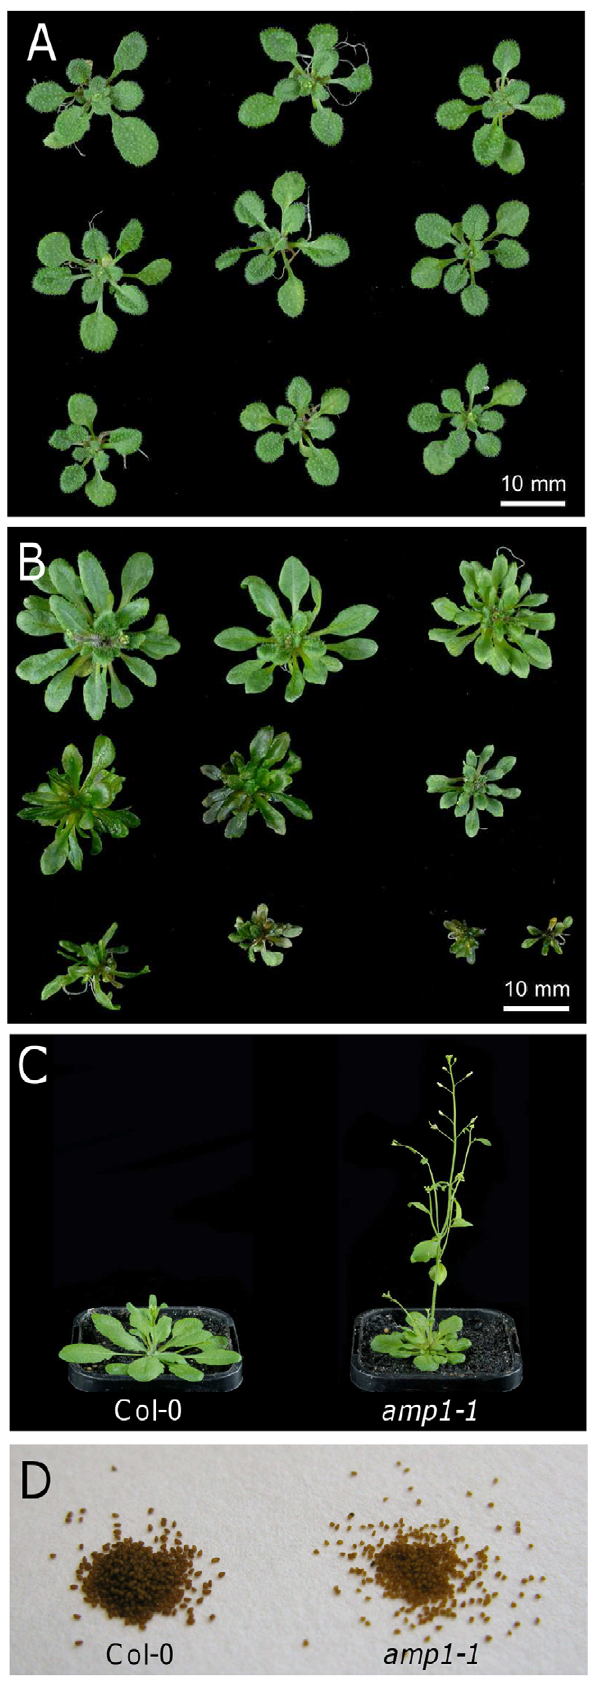
Figure 2. Phenotypes of amp1-1 . Rosettes of Col-0 (A) and amp1-1 (B) at 21 days after sowing. (C) Images of Col-0 and amp1-1 27 days after sowing. (D) Dry seeds from Col-0 and from amp1-1